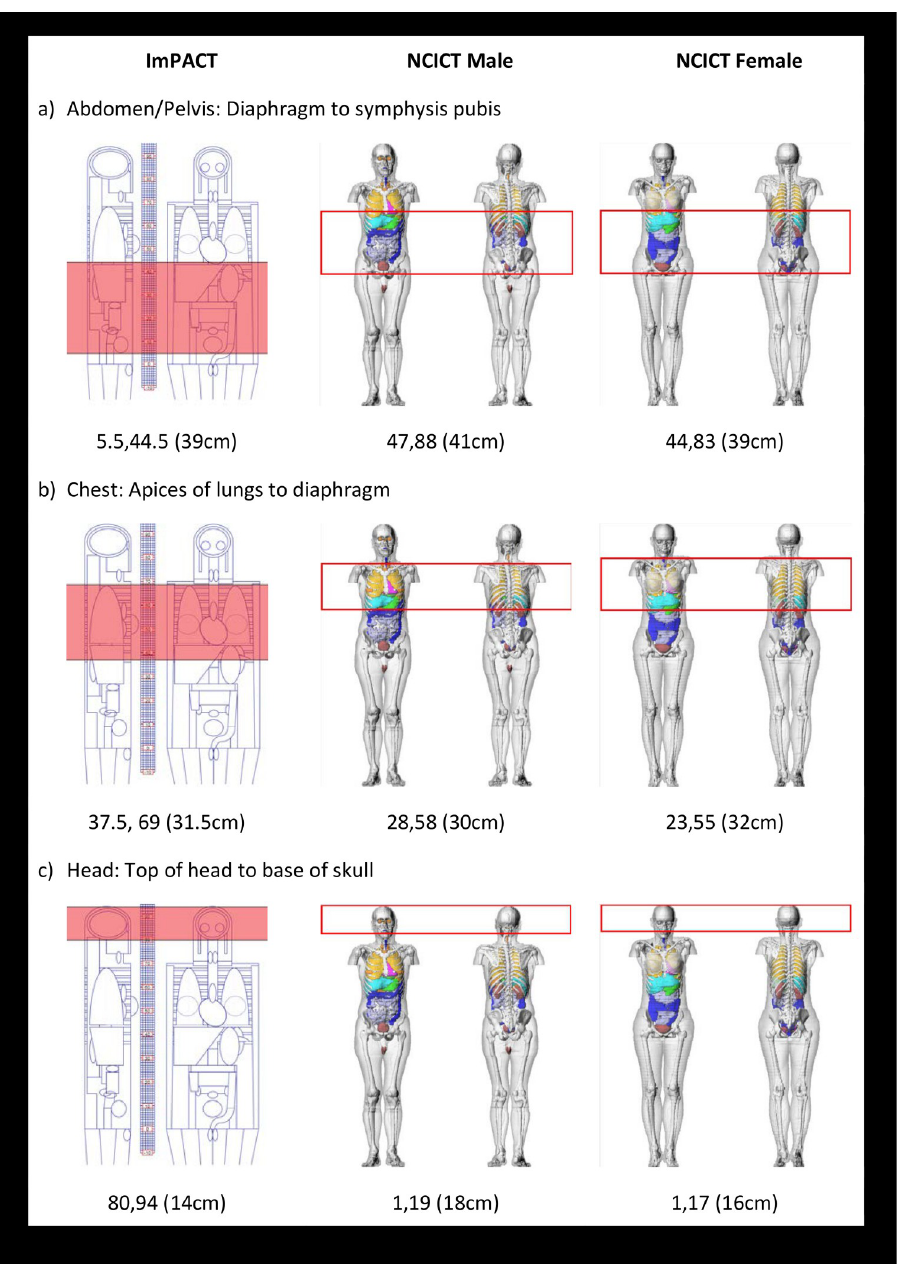
Fig 1. ImPACT and NCICT phantom scan start end positions for a) abdomen/pelvis b) chest and c) head protocols. Start and end measurements are indicated below each phantom diagram. Length of scan is shown in brackets. Phantom images are screenshots from ImPACT and NCICT software adapted to show stop start locations for the three protocols. anatomical positions were consistent with the typical anatomical reference start-end positions of these types of scans as identified by local medical imaging technologists[30]. CTDIvol in conjunction with scan start-end position and kV provided all the technical data necessary for the calculation of organ radiation dose. While the NCICT software based their dosimetry cal- culation on the CTDIvol, we were unable to input the CTDIvol directly into the ImPACT